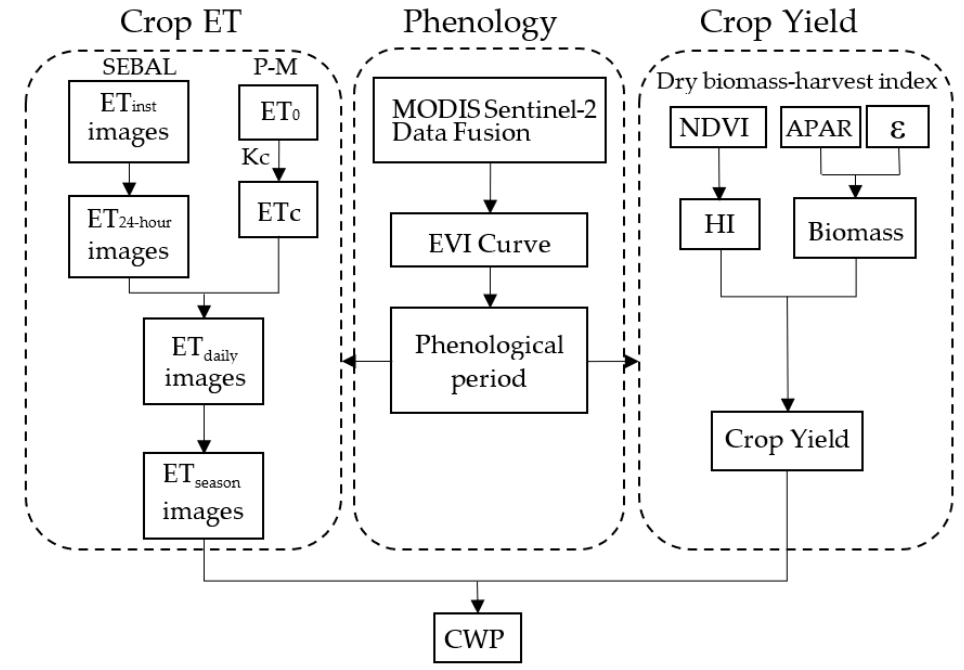
Figure 3. Flow chart of methods.